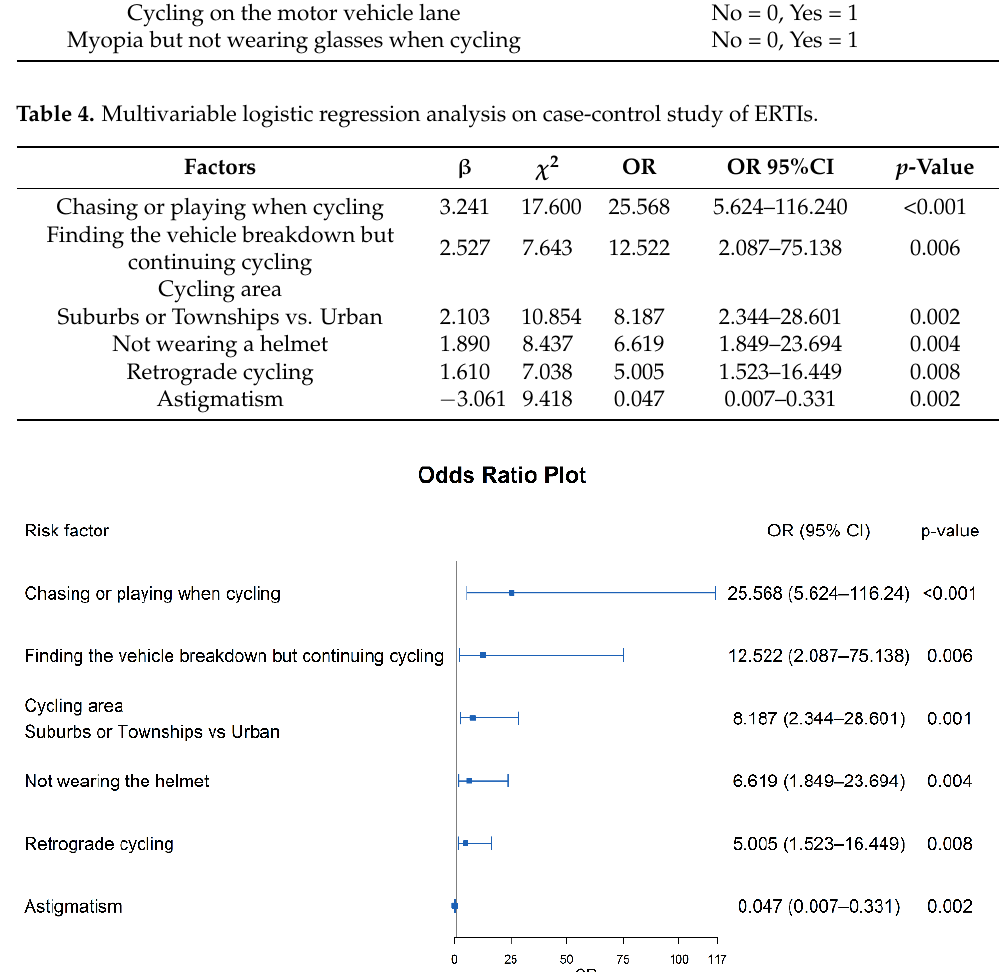
Figure 1. Forest plot of risk factors in the case-control study of ERTIs.